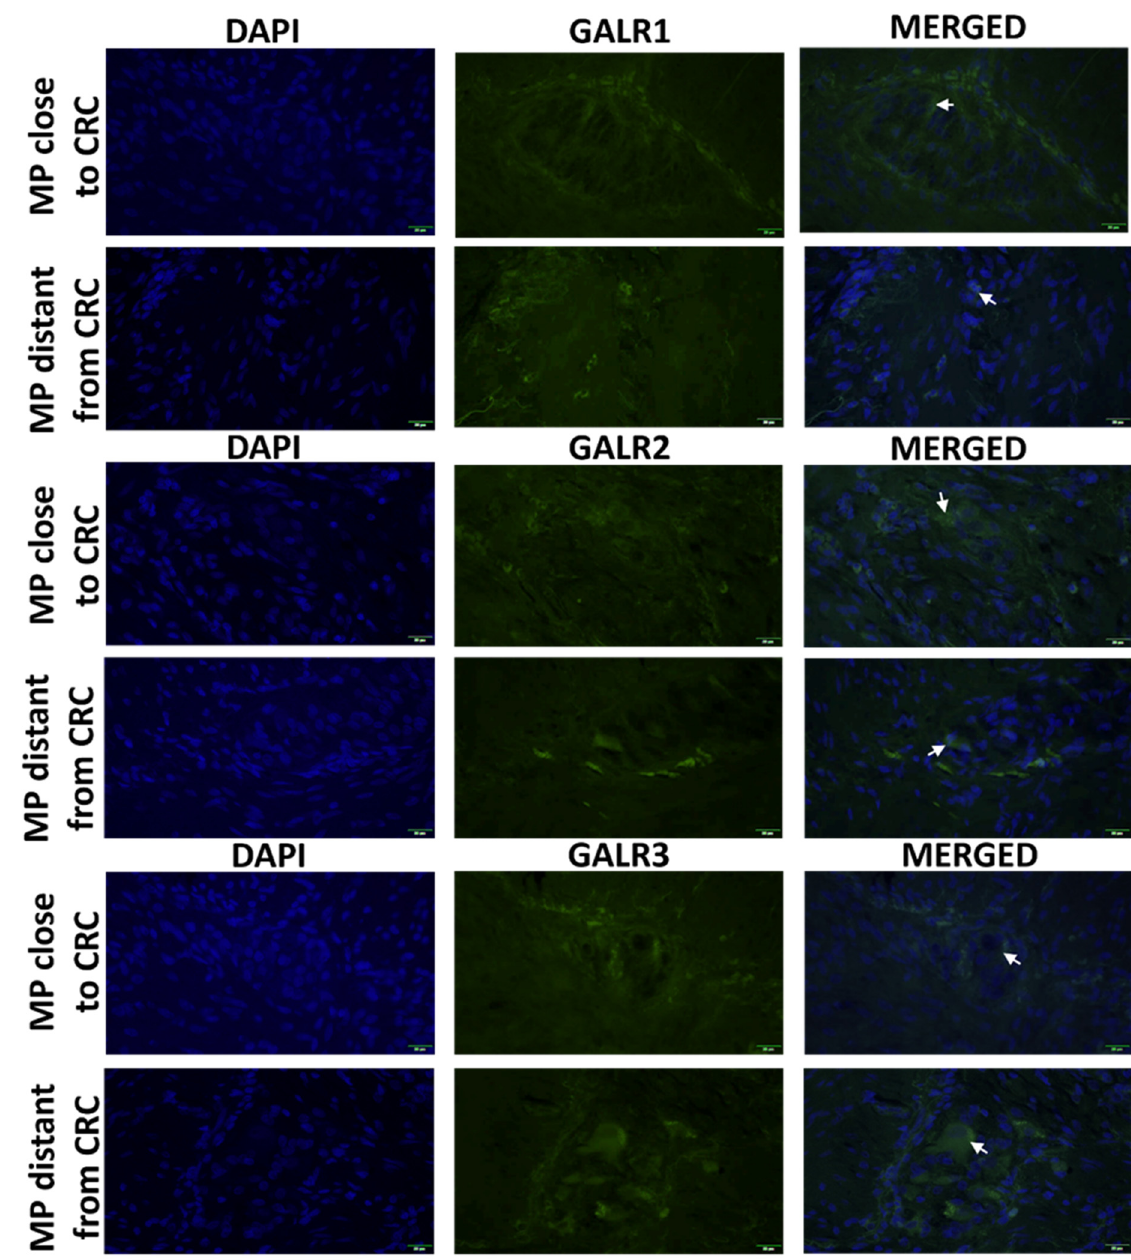
Figure 3. Immunolocalization of galanin receptors (GALR1, GALR2, and GALR3) in myenteric plex- uses (MP) close and distant to tumour tissue of CRCpatients (n = 5). Neurons expressing respective GALRs are marked by arrows. Total magnification: 400×.